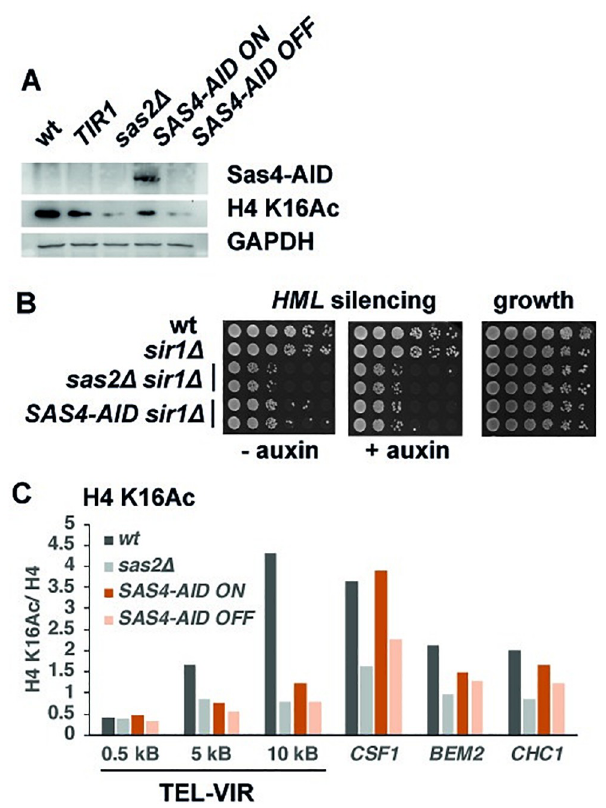
Fig 1. Establishment of an auxin-regulated version of the SAS-I component SAS4 . (A) SAS4-AID (SAS4-AID) downregulation by addition of auxin (OFF) caused a reduction of bulk H4 K16Ac. Top, Detection of myc-tagged Sas4-miniAID by Western blotting with an α -myc antibody; middle, α -H4 K16Ac; bottom, GAPDH (loading control). (B) Sas4-AID provided Sas4 function in HML silencing. Semi-quantitative mating of the indicated MAT a strains in the presence or absence of auxin is shown. (C) Reduction of H4 K16Ac levels by downregulation of Sas4-AID at subtelomeric regions on the right arm of telomere VI (TEL-VIR) and selected genes, as measured by ChIP. Means of two independent biological replicates of H4 K16Ac relative to H4 are